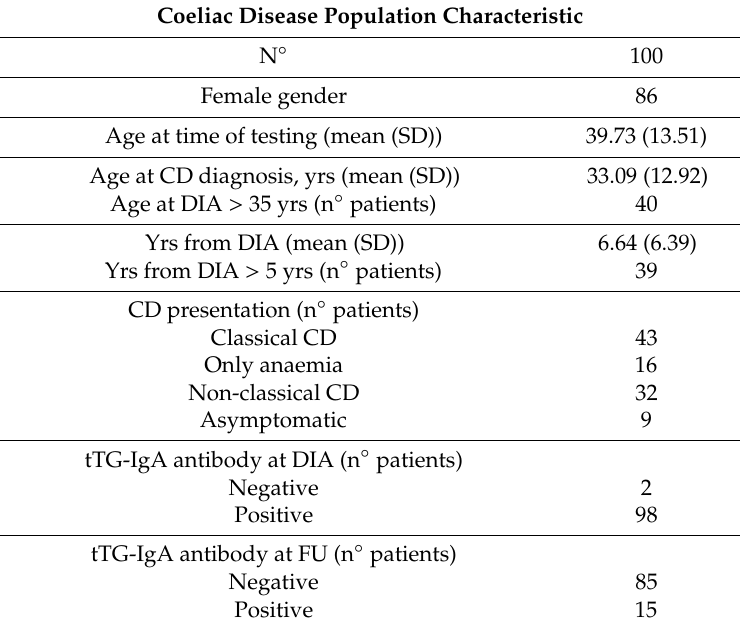
Table 1. Study population